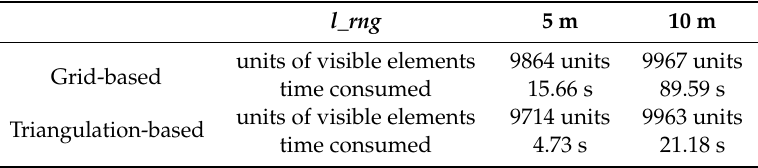
Table 5. Comparison between di ff erent l_rng in structural phase of case study